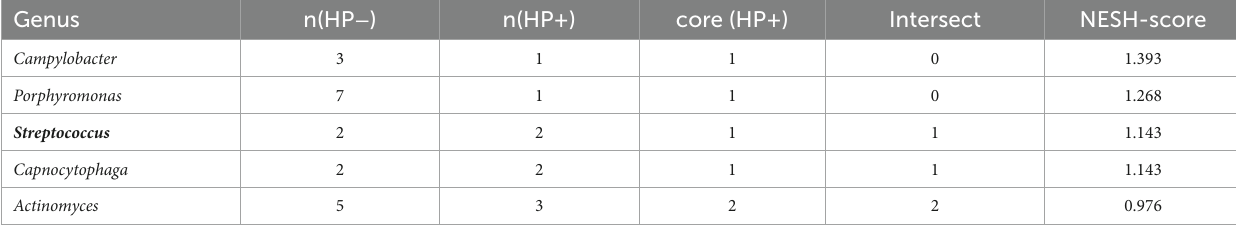
TABLE 2 Genera with the top five NESH score in Netshift